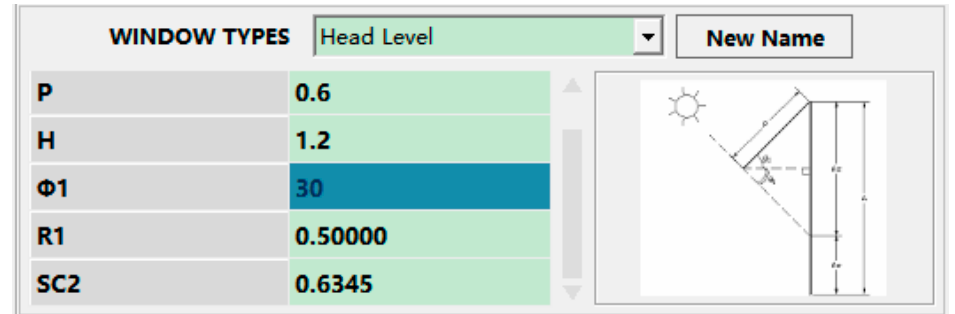
Figure 13. SC2 calculation by using the ETTV Guide table.